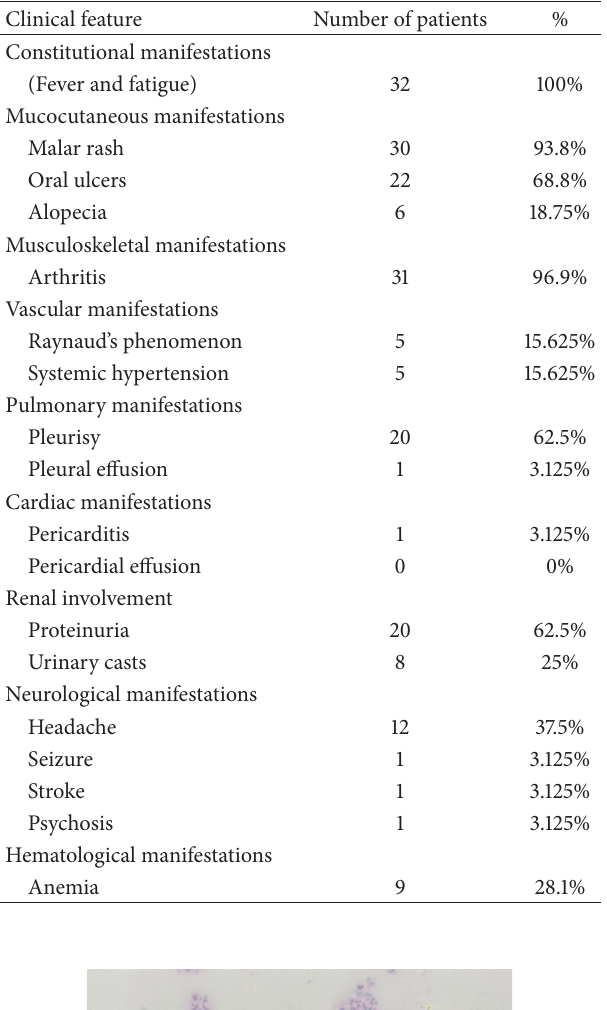
Table 1: Showing percentage of each clinical manifestations of SLE patients.